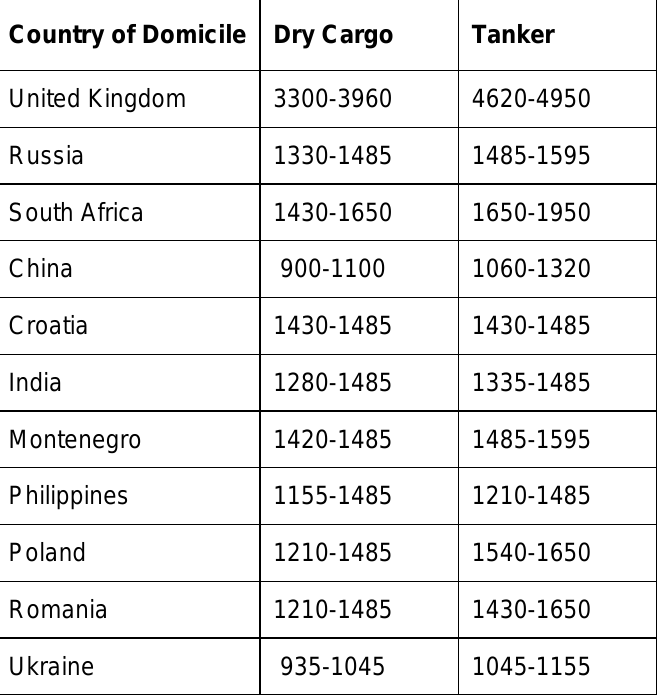
Table 1: Monthly On-board Earnings for Ratings in 2008